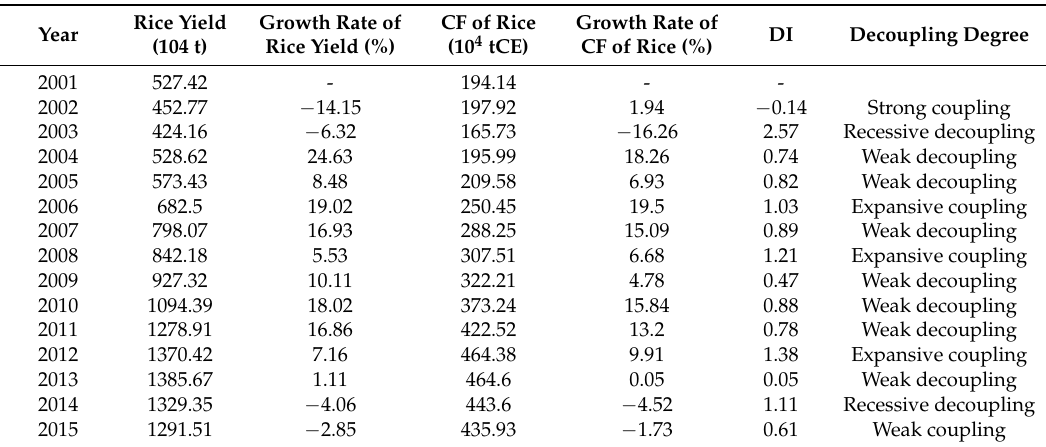
Table 5. Decoupling GHG emissions from rice production in the HLRA.